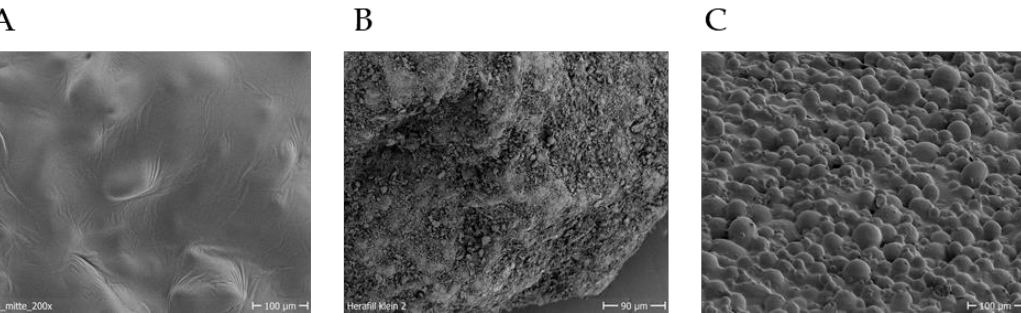
Figure 2. SEM images of the individual material surfaces. Different surface topographies of the individual materials are revealed. ( A ) poly(lactic-co-glycolic acid; ( B ) calcium sulphate/phosphate (Herafill); ( C ) polymethyl methacrylate.